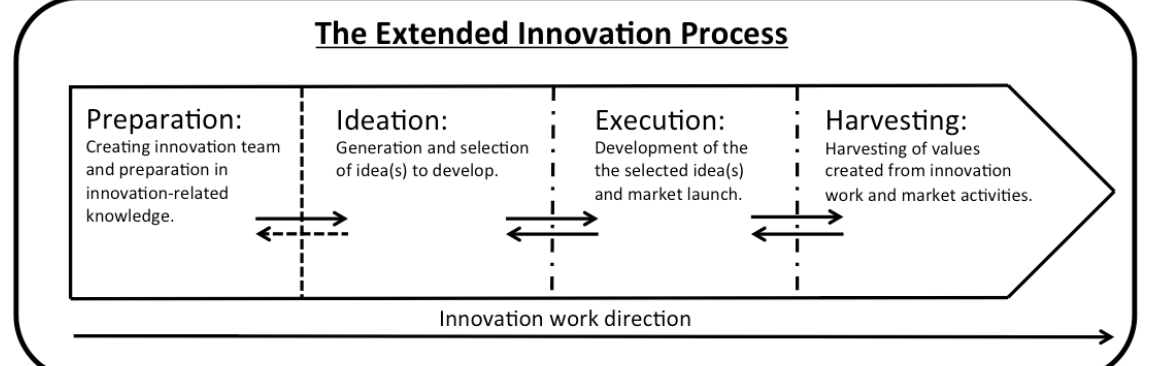
Fig. 9 . The Extended Innovation Process